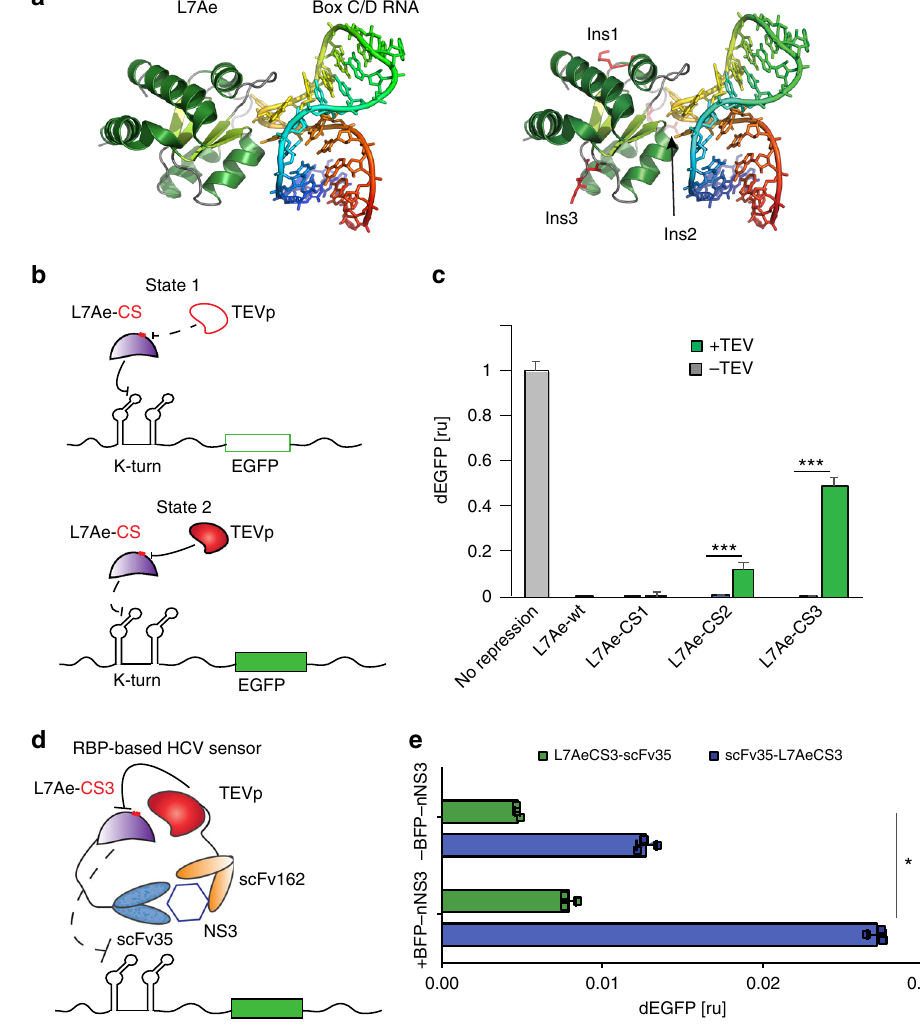
Fig. 1 Engineering a TEVp responsive L7Ae. a Structure of L7Ae binding to box C/D RNA that forms a K-turn motif. TCS insertion sites in L7Ae were placed after amino acid residue N70 (L7Ae-CS1), P56 (L7Ae-CS2), or K77 (L7Ae-CS3), shown in red for each site. Protein structure was determined in 33 (PDB id: 1RLG). L7Ae-CS structure visualization was performed with pymol 65 . b Schematics of L7Ae with inserted TCS translational regulation. In the absence of TEVp, L7Ae-CS binds and repress the K-turn motifs in the 5 ‘ UTR of mRNA target (EGFP OFF-State 1). When TEVp is expressed, it cleaves the TCS, disrupting L7Ae structure and inhibiting its function (EGFP ON-State 2). c Flow cytometry analysis of three engineered L7Ae-CS tested in HEK293 cells in the absence or presence of TEVp. Data represent geometric mean of dEGFP normalized by transfection marker mKate expressed from the same constitutive promoter to account for different expression across the cell lines. ru, relative units. Signi fi cant changes determined by unpaired t -test are indicated with asterisks *** p -value < 0.001 n = 3 replicates. d Schematics of L7Ae-CS3-based HCV sensor. TEVp-scFv162 16 and L7AeCS3-scFv35 fusion proteins are modules of a sensor for NS3 protein, which is associated with HCV virus. L7Ae-CS3 represses the mRNA target in the absence of NS3. In the presence NS3, binding of the intrabodies brings TEVp in proximity to L7Ae-CS3, resulting in cleavage of the RBP and derepression of the target gene. e Test of the variants of NS3 sensor in the presence and absence of BFP-nNS3 16 . Data represent geometric mean and standard deviation of means of dEGFP normalized by transfection marker mKate, for n = 3 replicates. Signi fi cant changes determined by unpaired t -test are indicated with asterisks * p -value